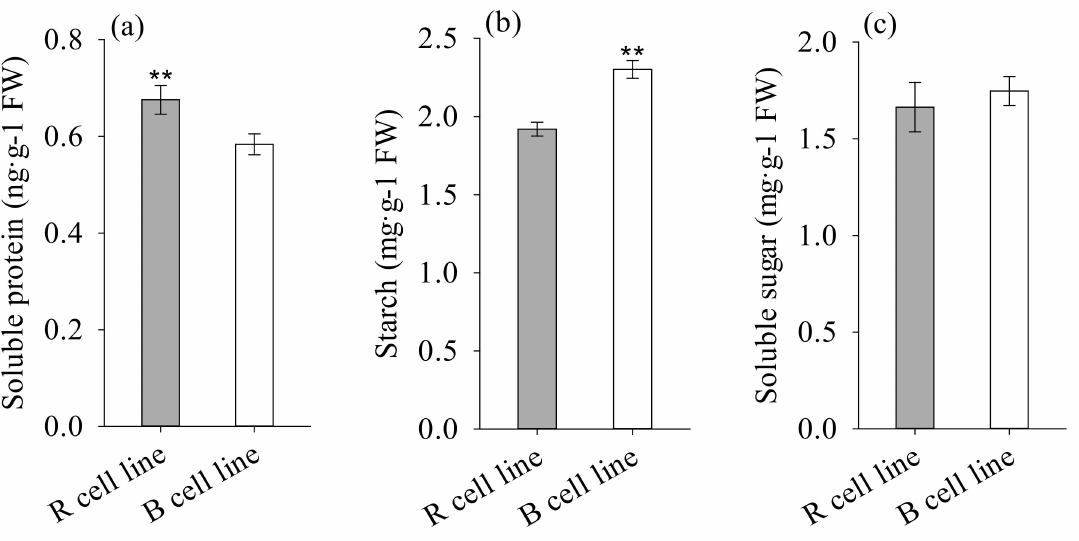
Figure 8. Differences in soluble protein, starch, and soluble sugar contents between P. koraiensis R and B cell lines. ** above the column indicates that the difference is significant at the p < 0.01 level. The highest soluble protein, soluble sugar, and starch contents were observed in the 1-1, 1-102, and 1-102 cell lines, respectively (mean = 0.862 mg · mg − 1 FW, 3.013 mg · mg − 1 FW, and 2.329 mg · mg − 1 FW, respectively; Figure 9). In addition, it was also discovered that the soluble protein content was positively correlated with cotyledonary SE yield (R = 0.212, p = 0.026) and PE III number (R = 0.355, p < 0.001). The starch content was negatively correlated with cotyledonary SE yield (R = − 0.453, p < 0.001) and the numbers of PE III (R = − 0.377, p < 0.001) and ESEs (R = − 0.329, p < 0.001). The soluble sugar content was negatively correlated with the number of PE III (R = − 0.236, p = 0.013; Figure 5).